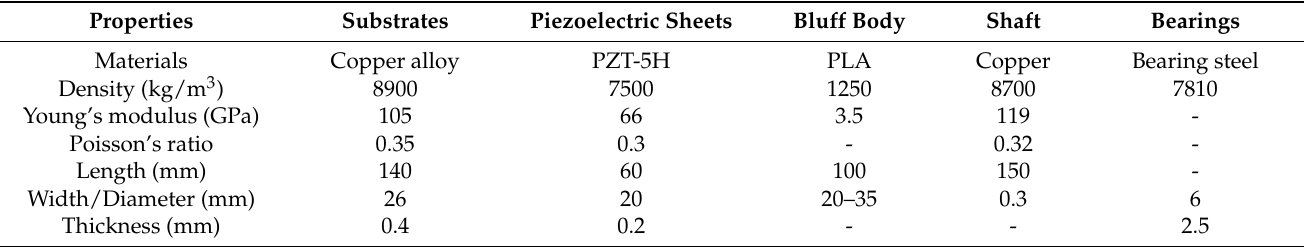
Table 1. Materials and parameters of each part of the VFPEH.